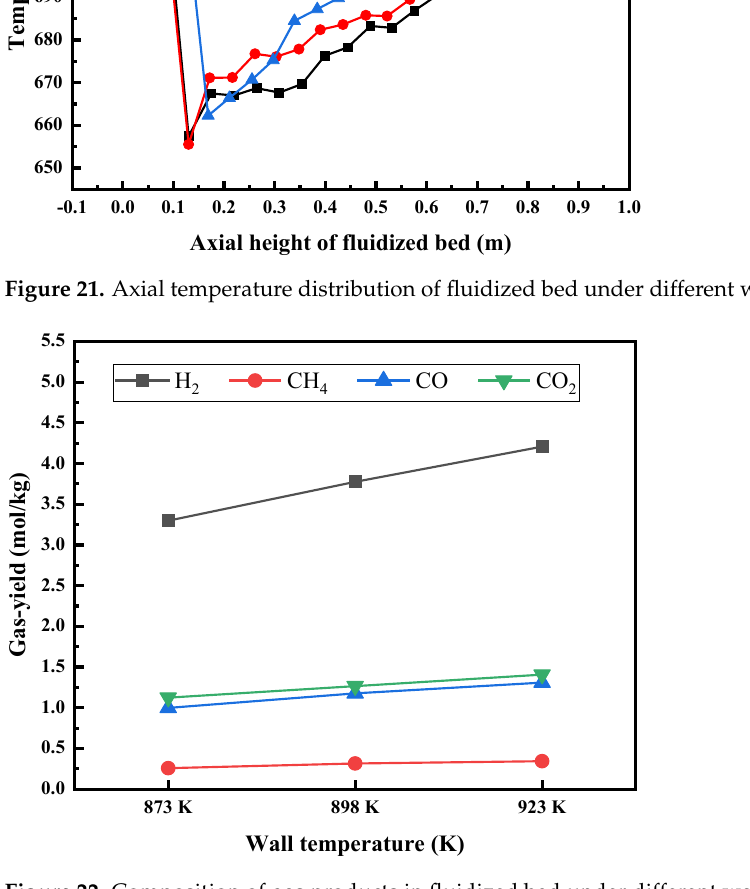
Figure 22. Composition of gas products in fluidized bed under different wall temperatures.